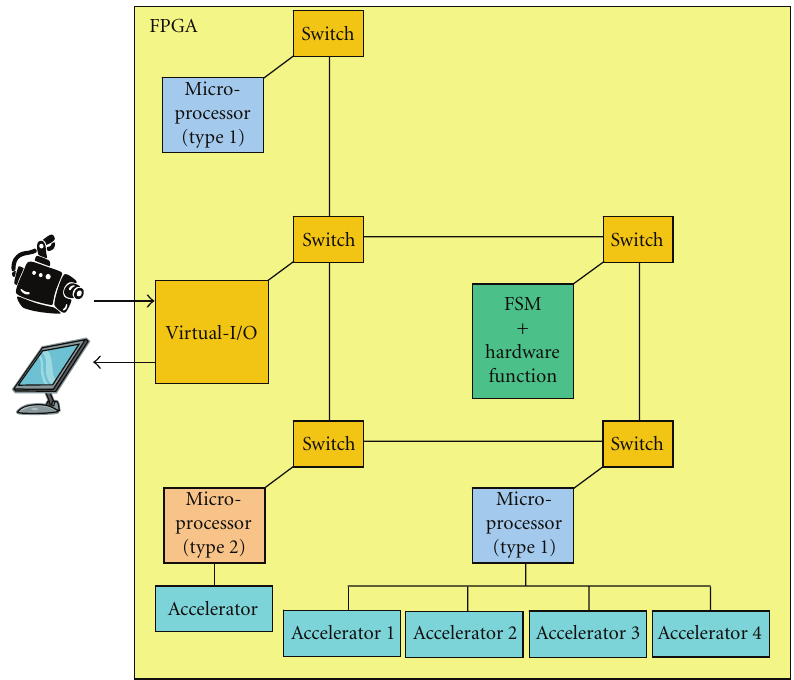
Figure 5: RAMPSoC system at one point in